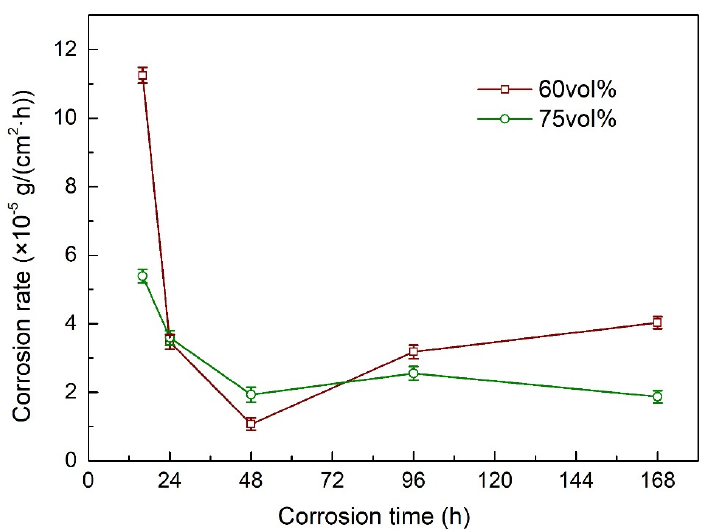
Figure 4. Corrosion rate of Diamond/Cu composites with different diamond content in neutral salt spray test.